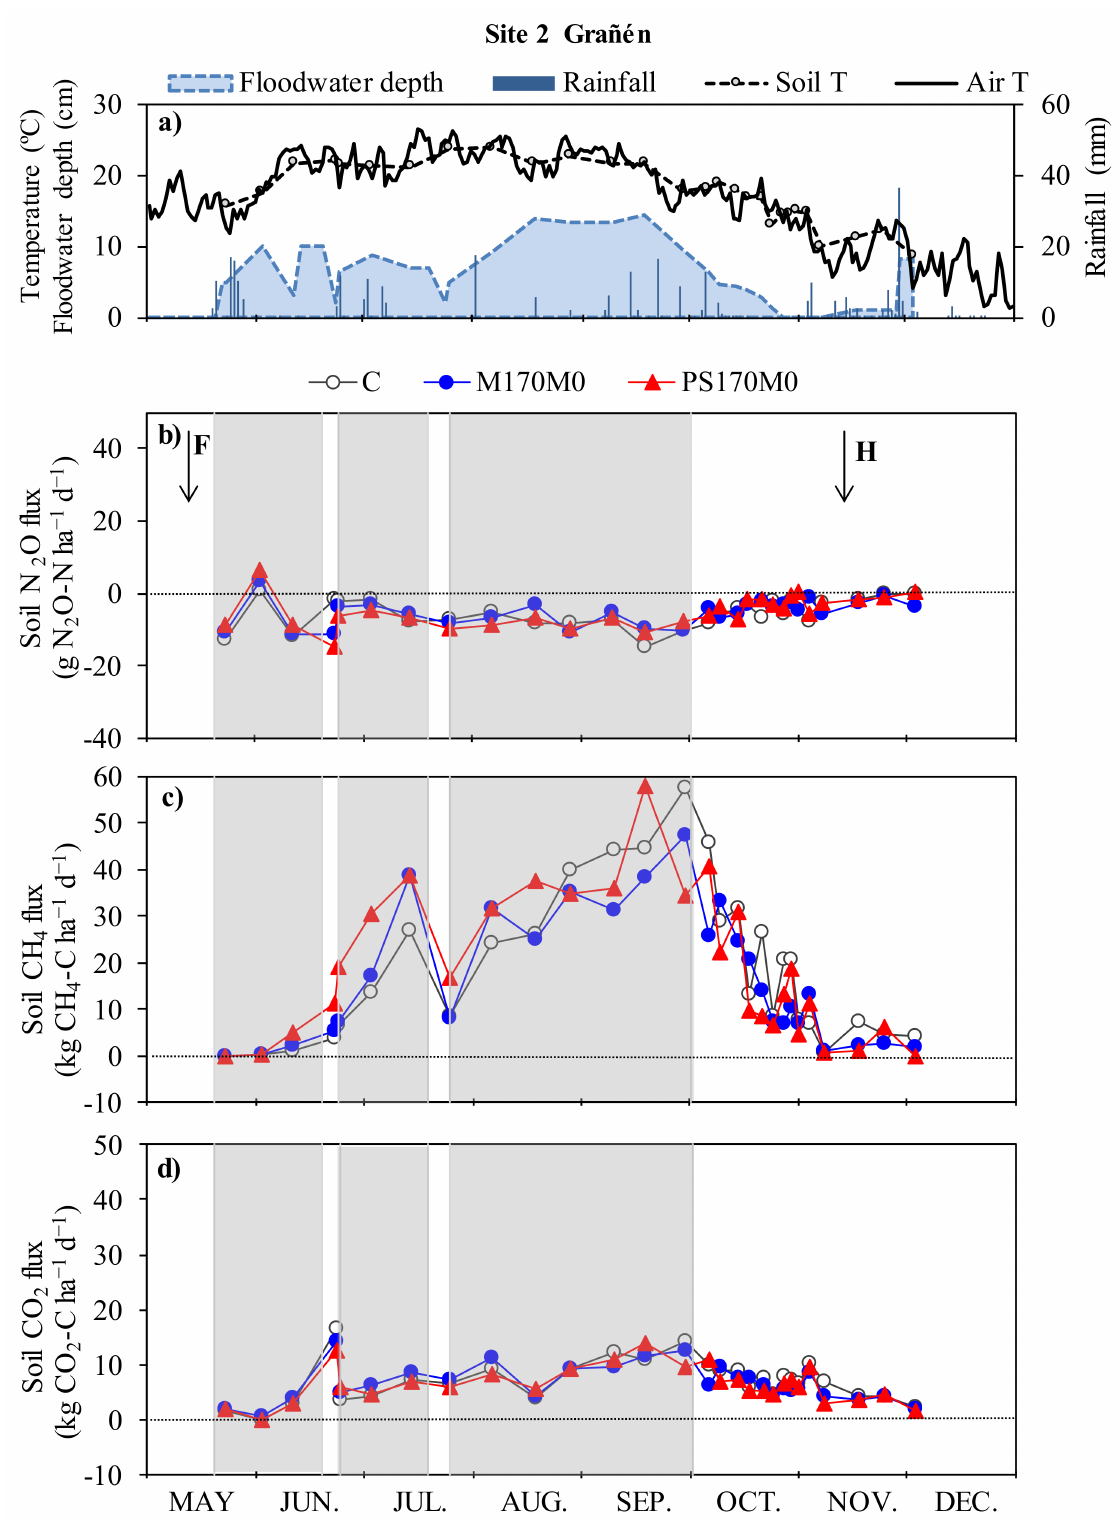
Figure 3. Site 2 (Grañ é n) year 2014. ( a ) Soil and air temperature, rainfall, and floodwater depth during the studied period; and ( b ) N 2 O, ( c ) CH 4 , and ( d ) CO 2 emissions as a ff ected by the fertilization treatments. Vertical arrows indicate the dates of fertilization applications (F) and harvest (H). The grey shaded areas represent the periods in which the water inflow to the field was open. Note that once water was stopped, the field remained flooded for several